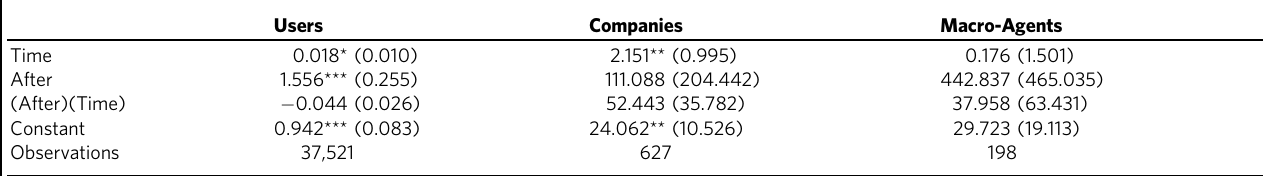
Table 4. Number of partners per node — 90-day spans.